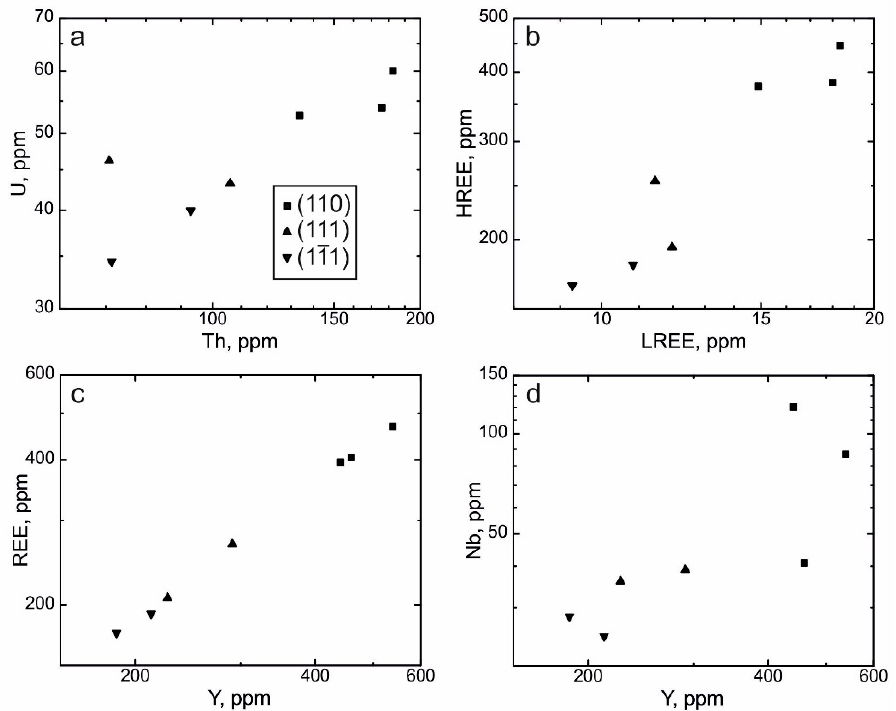
Figure 7. ( a ) Th versus U; ( b ) LREE versus HREE; ( c ) Y versus REE; ( d ) Y versus Nb in the second growth zone of zircon (points 6, 14, 22, 29, 41, и 50).